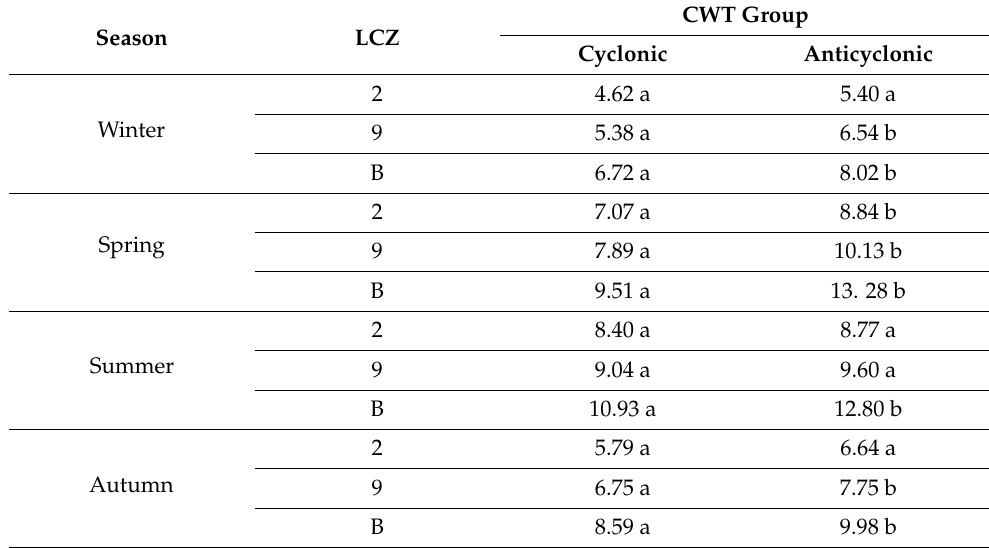
Table 5. Significance of DTR variation among CWT groups for each Season and each LCZ. Average values [ ◦ C] are shown. Letters a, b represent significant differences among groups.